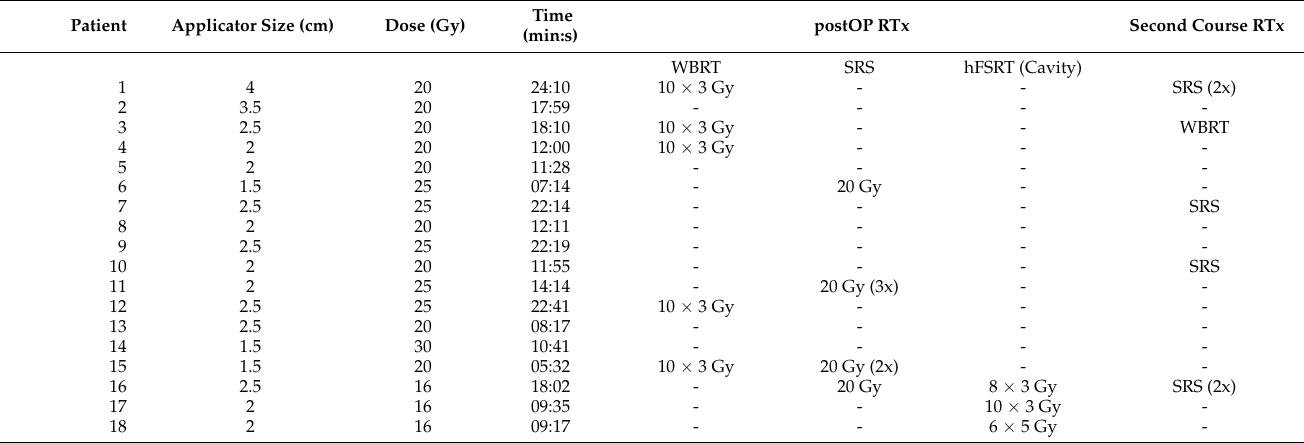
Table 2. Radiation therapy related data for IORT and adjuvant RT and second-course